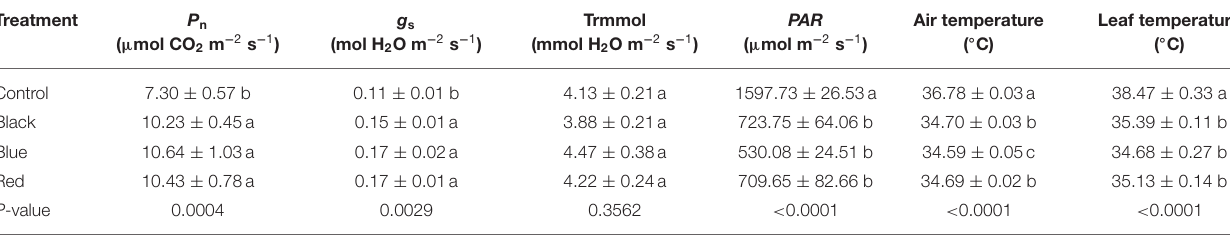
TABLE 1 | Photosynthetic characteristics of tea plants under different color shade